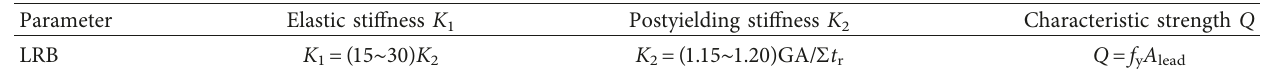
Table 3: Formulas of the mechanical parameters of LRB.